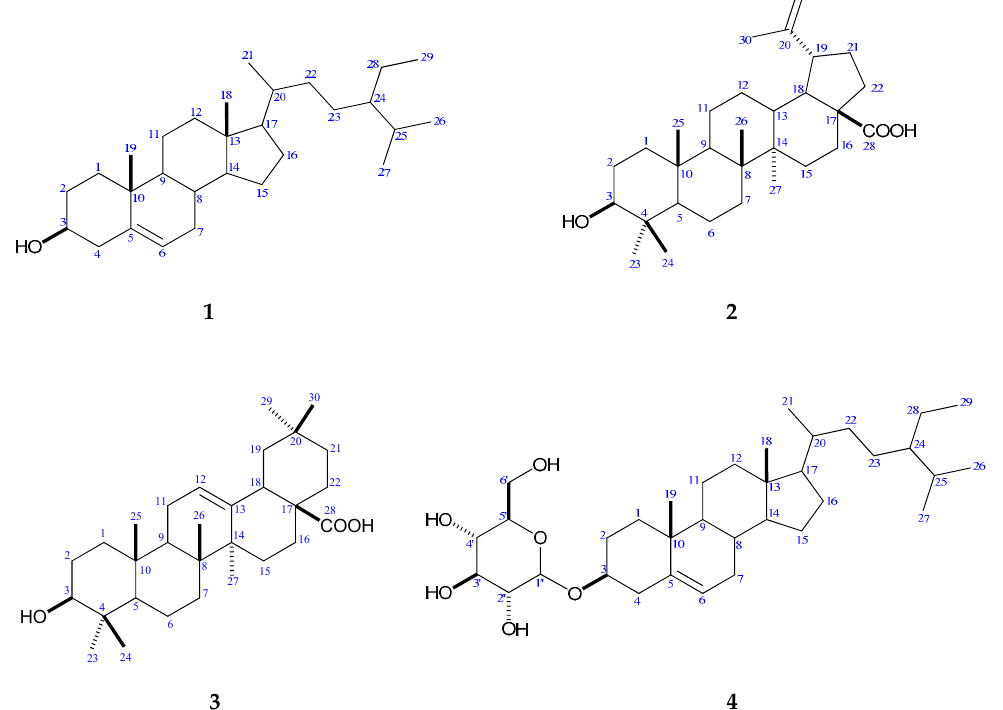
Figure 5. The structure of the tentatively identified compounds in the dichloromethane fraction of S. hispanica L. aerial parts. ( A ) Phenolic acid derivatives, ( B ) miscellaneous compounds.